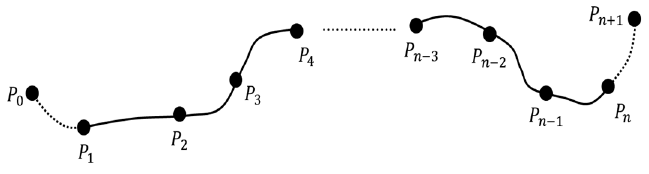
Figure 4. Path for multiple knots from P 1 to P n .